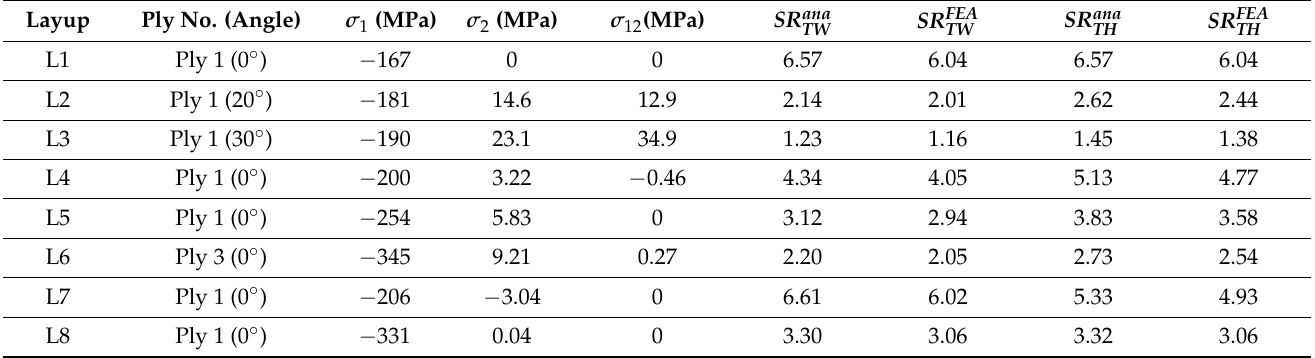
Table A2. Comparison of plies with minimum safety ratios (SRs) for the “SSS” beam (flange under compression; stress values are in MPa); see Figure 3c for a laminate stacking sequence sample.